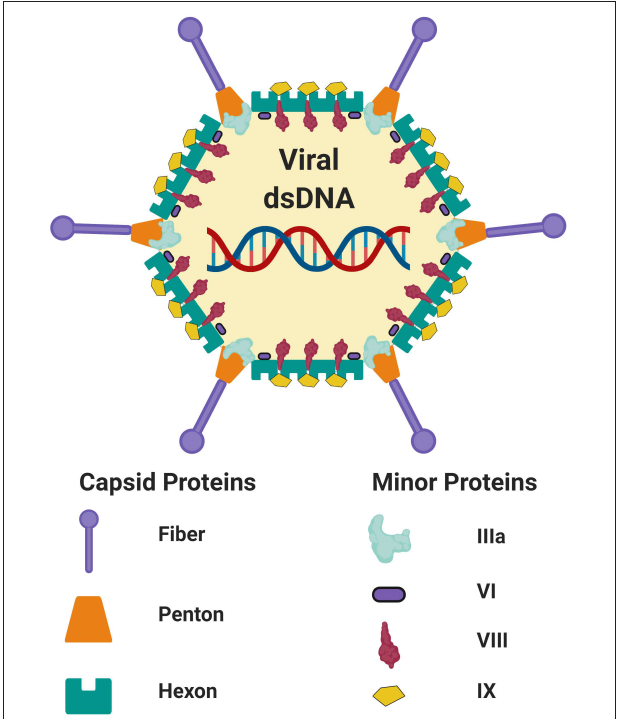
FIGURE 1 | Schematic adenovirus structure. Schematic representation of the capsid and minor structural proteins of an adenovirus. Internal core proteins are not shown. The adenoviral virion contains linear double-stranded DNA genome (dsDNA). Figure is adapted from Russell ( 17) and was created with © BioRender - biorender.com. Proteins are not to